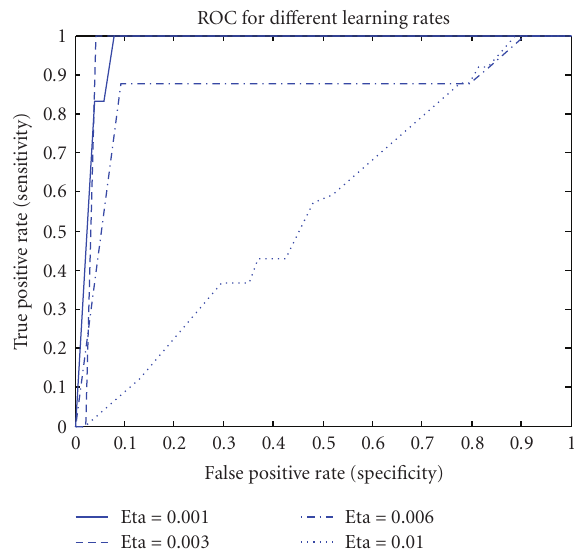
Figure 8: ROC plot for di ff erent values of the learning rate for testing set number